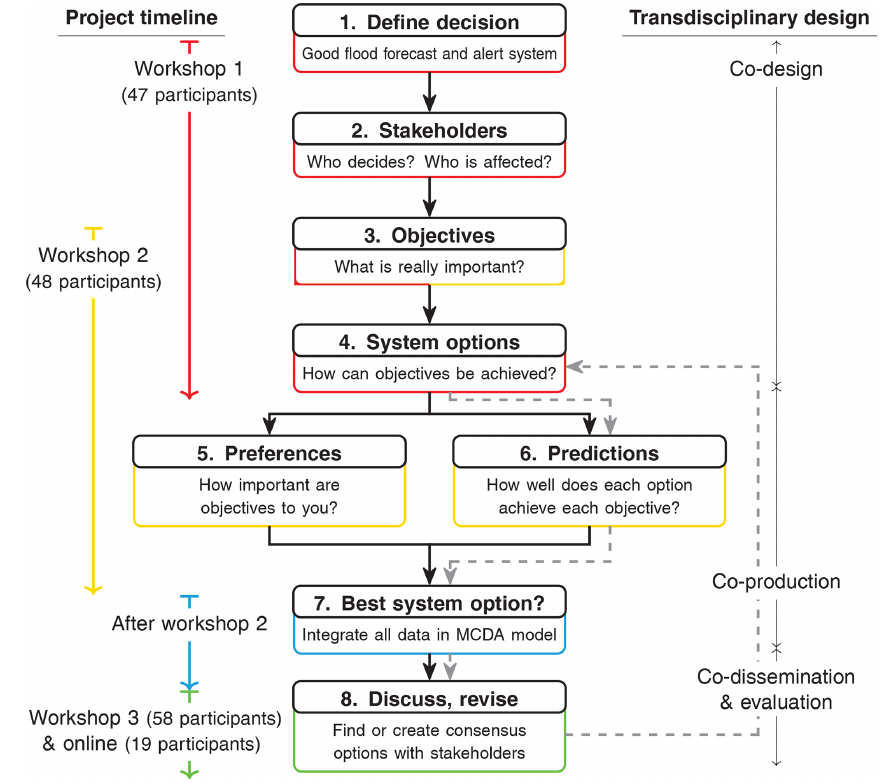
Figure 1. Multi-criteria decision analysis (MCDA) was carried out stepwise in the FANFAR project. For explanations, see the text.